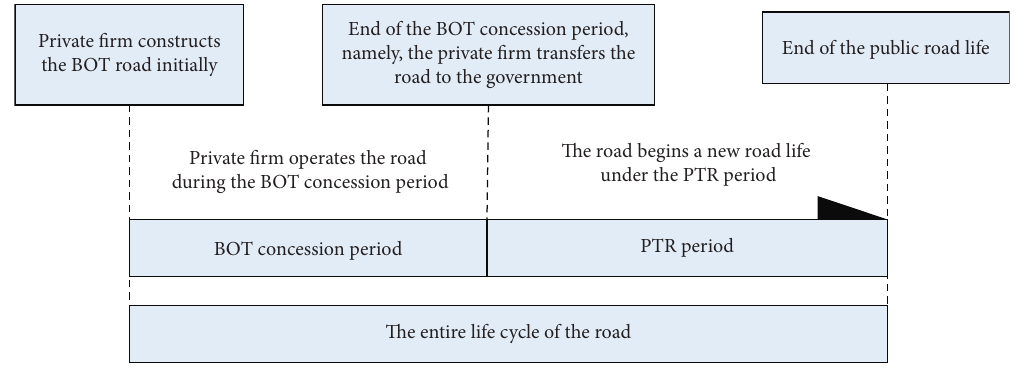
Figure 1: Relationship of the BOT concession period and PTC